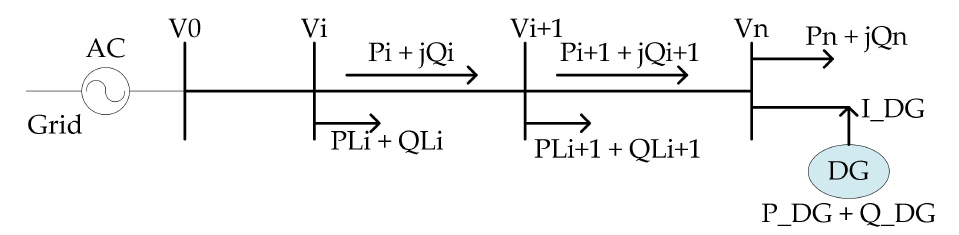
Figure 3. Distribution network with DG